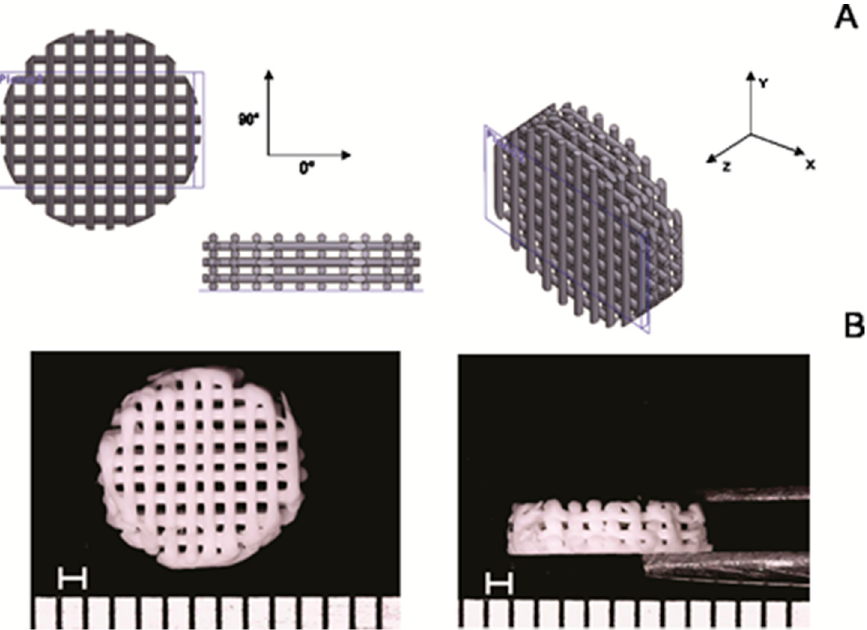
Figure 1. PLA scaffold design. The computer-aided design (CAD) model of scaffolds ( A ); Representative macrographs of printed PLA scaffolds ( B ) (Scale bar = 1 mm).